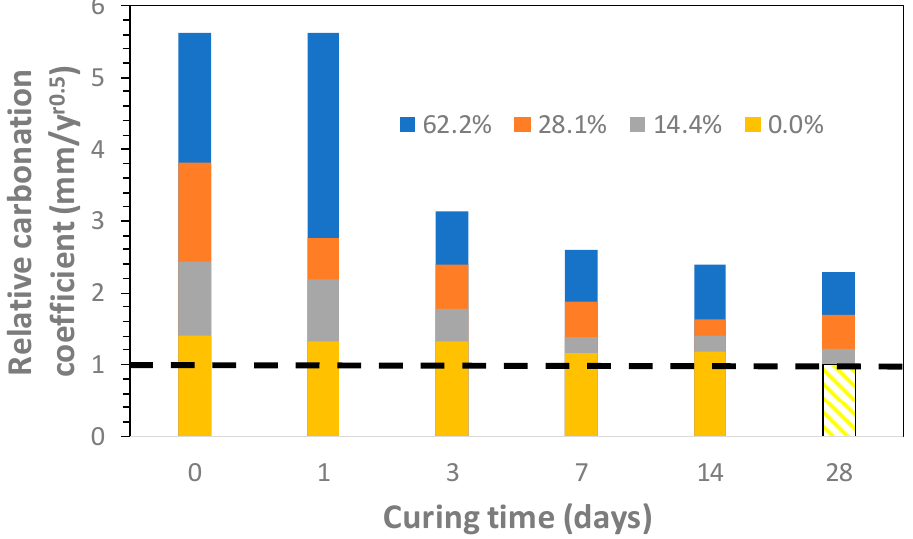
Figure 2. Relative carbonation coefficient, B , calculated after 2 years of natural carbonation in mortars made with ground granulated blast-furnace slag (GGBFS), which have been cured for 0, 1, 3, 7, 14 and 28 days (The reference value (one) is represented by a broken line in black color: 0% slag and 28 days of curing underwater).